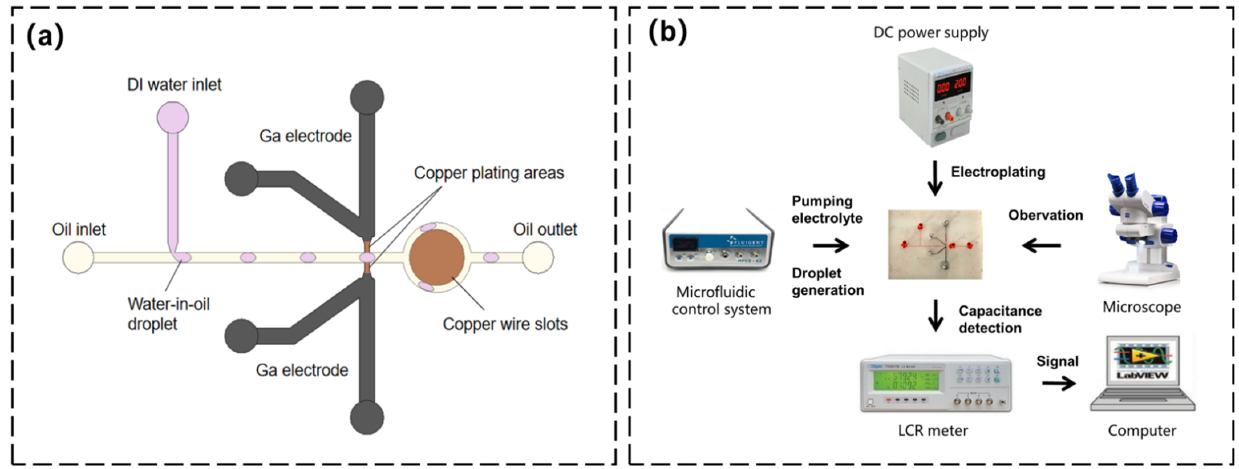
Figure 7. ( a ) The structure of a droplet detection sensor based on the microelectroplating electrode. ( b ) Diagram of the test setup. ( b ) Diagram of the test setup.